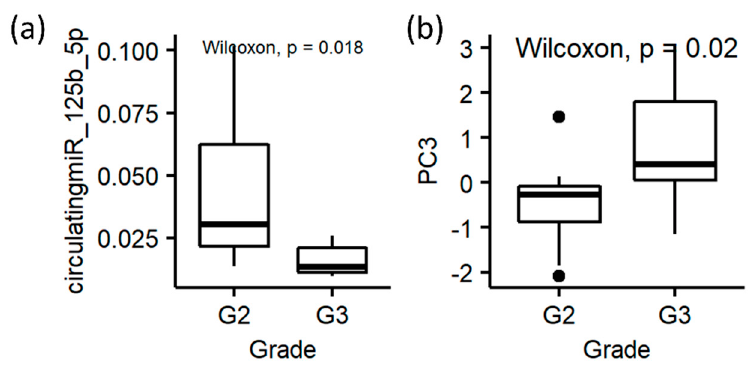
Figure 4. Box plots for tumor grade (i.e., G2 and G3). ( a ) Circulating miRNA_125b_5p; ( b ) PC3 from the quantile